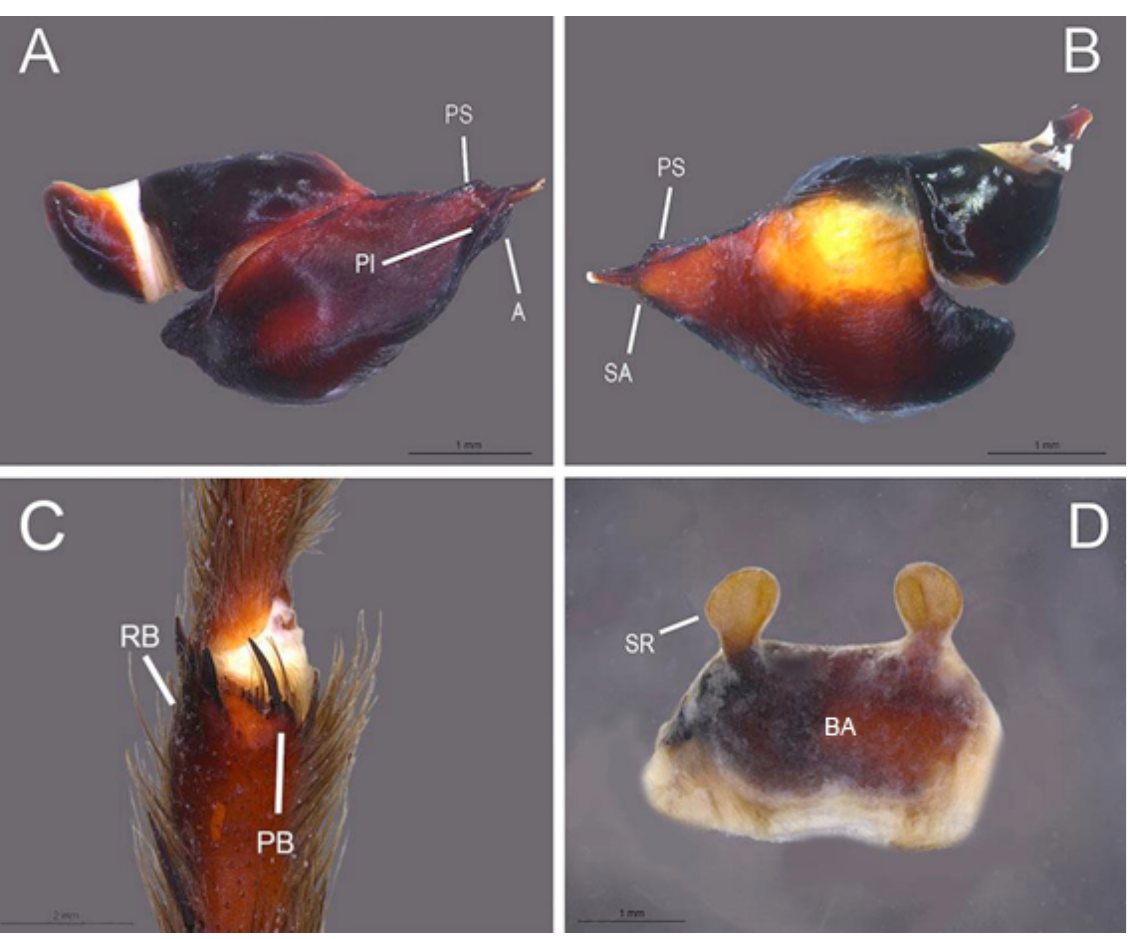
Fig. 7. Umbyquyra paranaiba gen. et sp. nov. A–C . Holotype, ♂ (IBSP 107411) . A . Palp, prolateral. B . Retrolateral. C . Tibial apophysis, ventral. D . Paratype, ♀ (IBSP 111695), spermathecae, dorsal. Abbreviations: see Material and